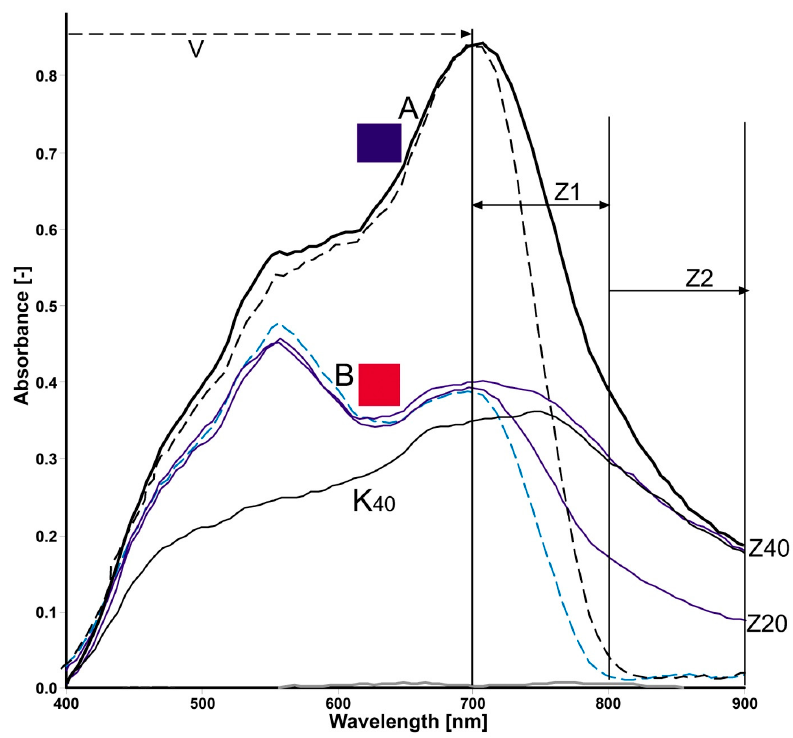
Figure 2. Twins A, B, K40.